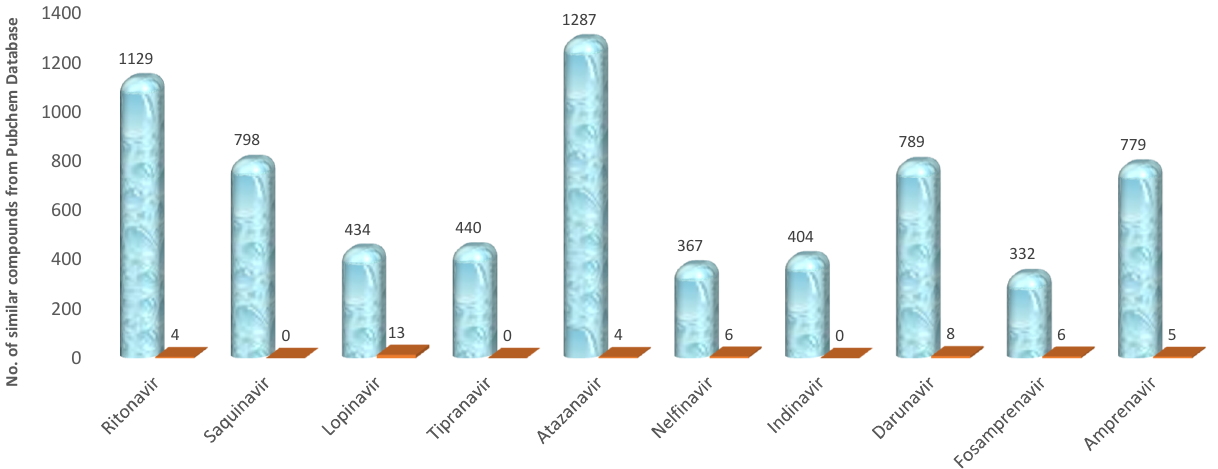
Figure 2. Similarity search outcome using different HIV I protease inhibitors as reference drugs.